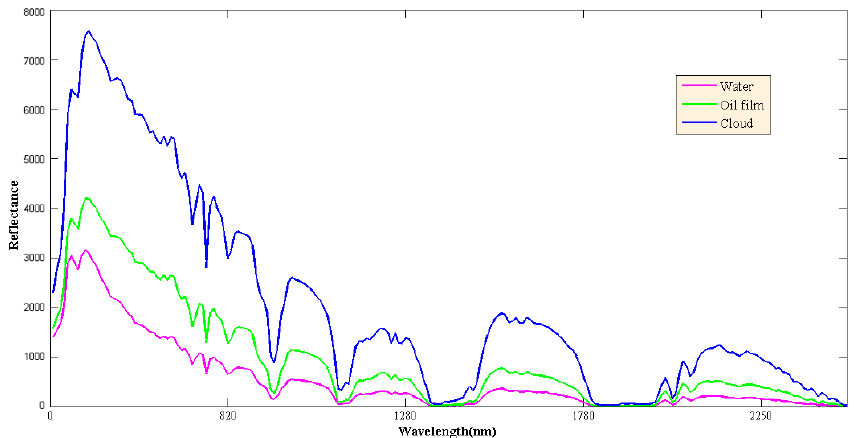
Figure 7. Endmember spectra.